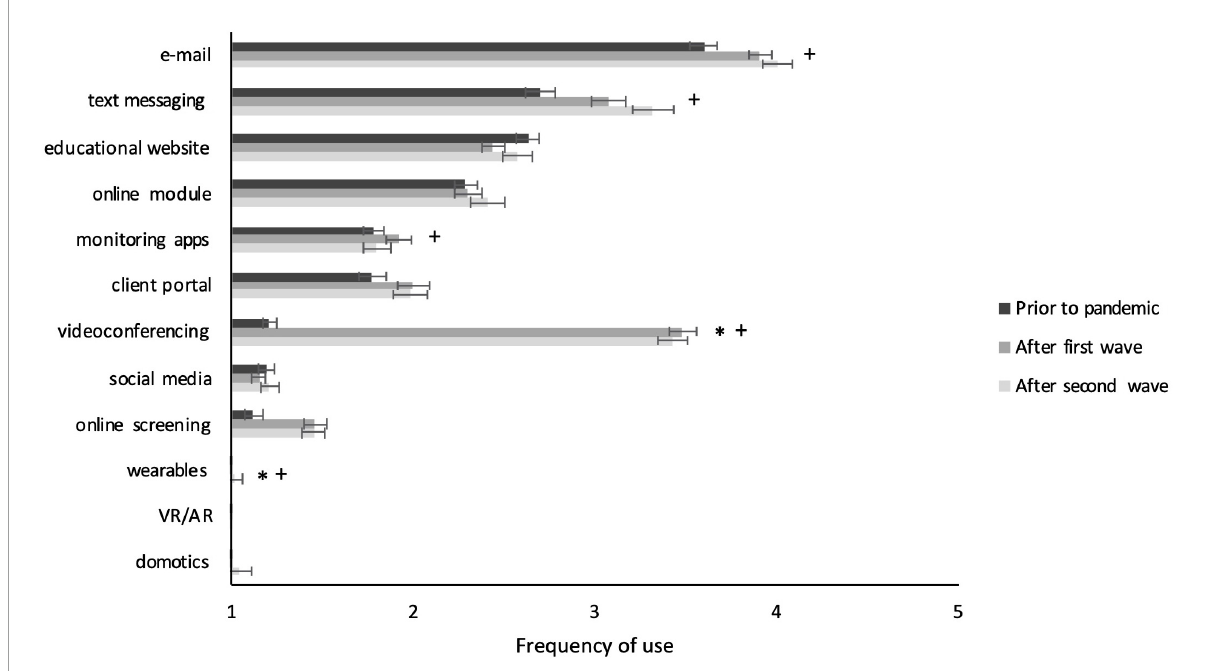
FIGURE2 Frequency of use of individual DMH tools per survey. Significant effects with Cohen’s d > 0.25 are indicated with ∗ for comparison between Survey 1 and 2 and with + for comparisons between Survey 1 and 3. Error bars present the standard error of the